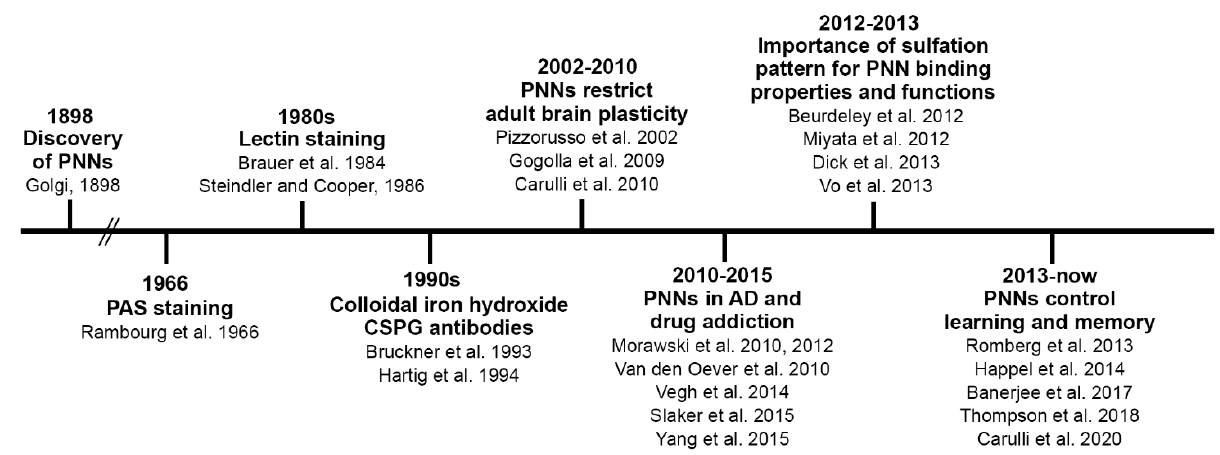
Figure 2. Timeline of key PNN-related discoveries. The timeline shows some of the critical contributions to the PNN field, from the first papers in which PNNs were visualized to the first studies elucidating PNN molecular composition and PNNs’ role in plasticity and disease. AD: Alzheimer’s disease, PAS: periodic acid–Schiff.